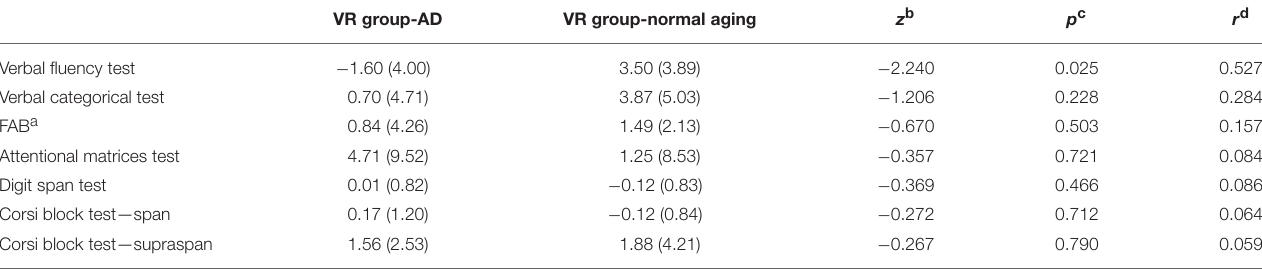
TABLE 5 | Pre-post assessment. VR group-AD VR group-normal aging